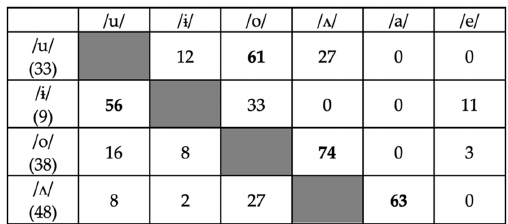
Figure 9. Confusion matrix of errors in the posttest for vowel items (vertical = stimuli, horizontal = responses). Each cell shows the percent of all errors on the given stimulus represented by the given response (rows may not add to 100% due to rounding); the most common error type for each stimulus is bolded. The total number of errors for each stimulus (across all groups) is shown in parentheses. As in the stop study, we further examined the relationship between pretest performance and posttest vowel perception via Pearson’s correlations. In line with the modeling results as well as the lack of correlations seen in the stop study, these analyses revealed no significant correlations between pretest performance and posttest accuracy on vowels, overall [ r (55) = 0.09, p > 0.05] or within either individual group: no ‐ contrast [ r (24) = 0.16, p > 0.05] or some ‐ contrast [ r (29) = − 0.002, p > 0.05] (see Figure 10). In short, results of the vowel study were consistent with those of the stop study: again, we found evidence of L1 transfer only in the posttest and no evidence of a link between preexisting phonetic sensitivity and L2 vowel perception after L2 learning.